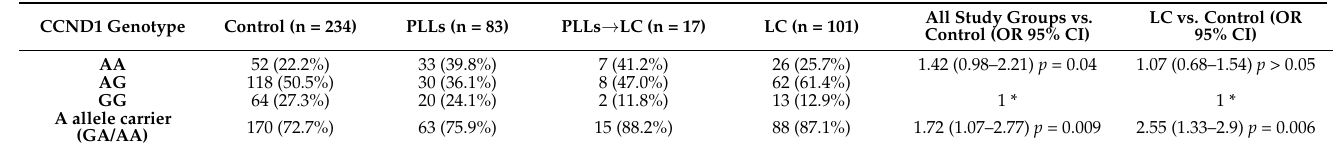
Table 2. Distribution of the CCND1 G870A polymorphism genotypes (* reference